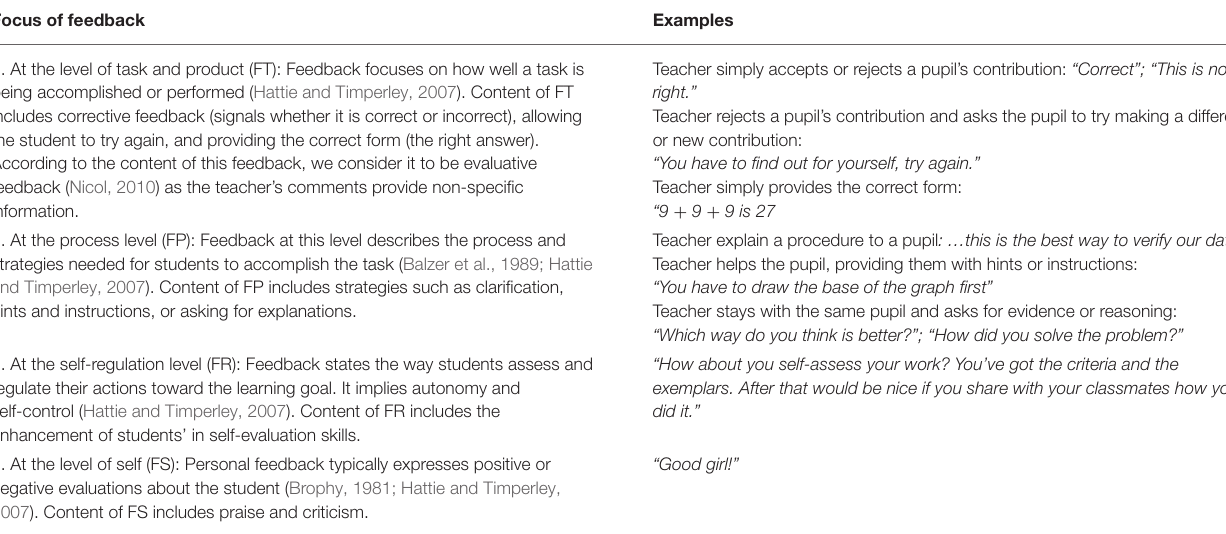
TABLE 1 | Focus of the feedback: the four levels (Hattie and Timperley, 2007). Focus of feedback